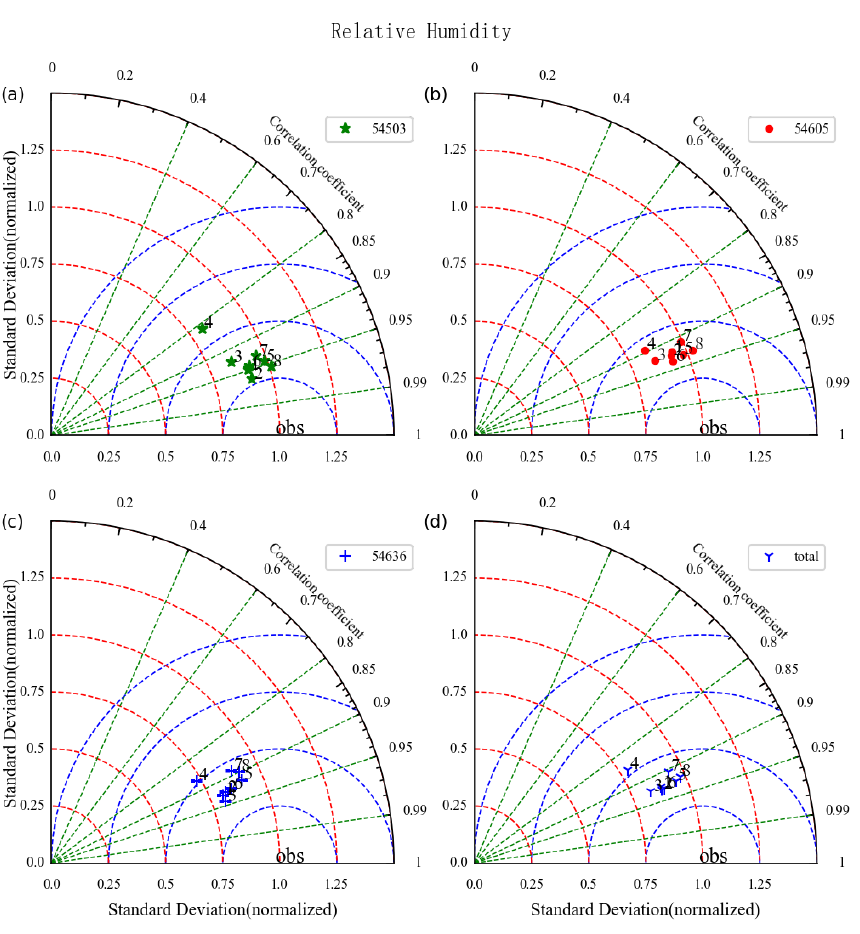
Figure 7. Taylor diagram of simulated and observed 2-m relative humidity values for different schemes during the simulation period at ( a ) Rongcheng: 54,503, ( b ) Xiongxian: 54,636, ( c ) Anxin: 54,605 and ( d ) total.